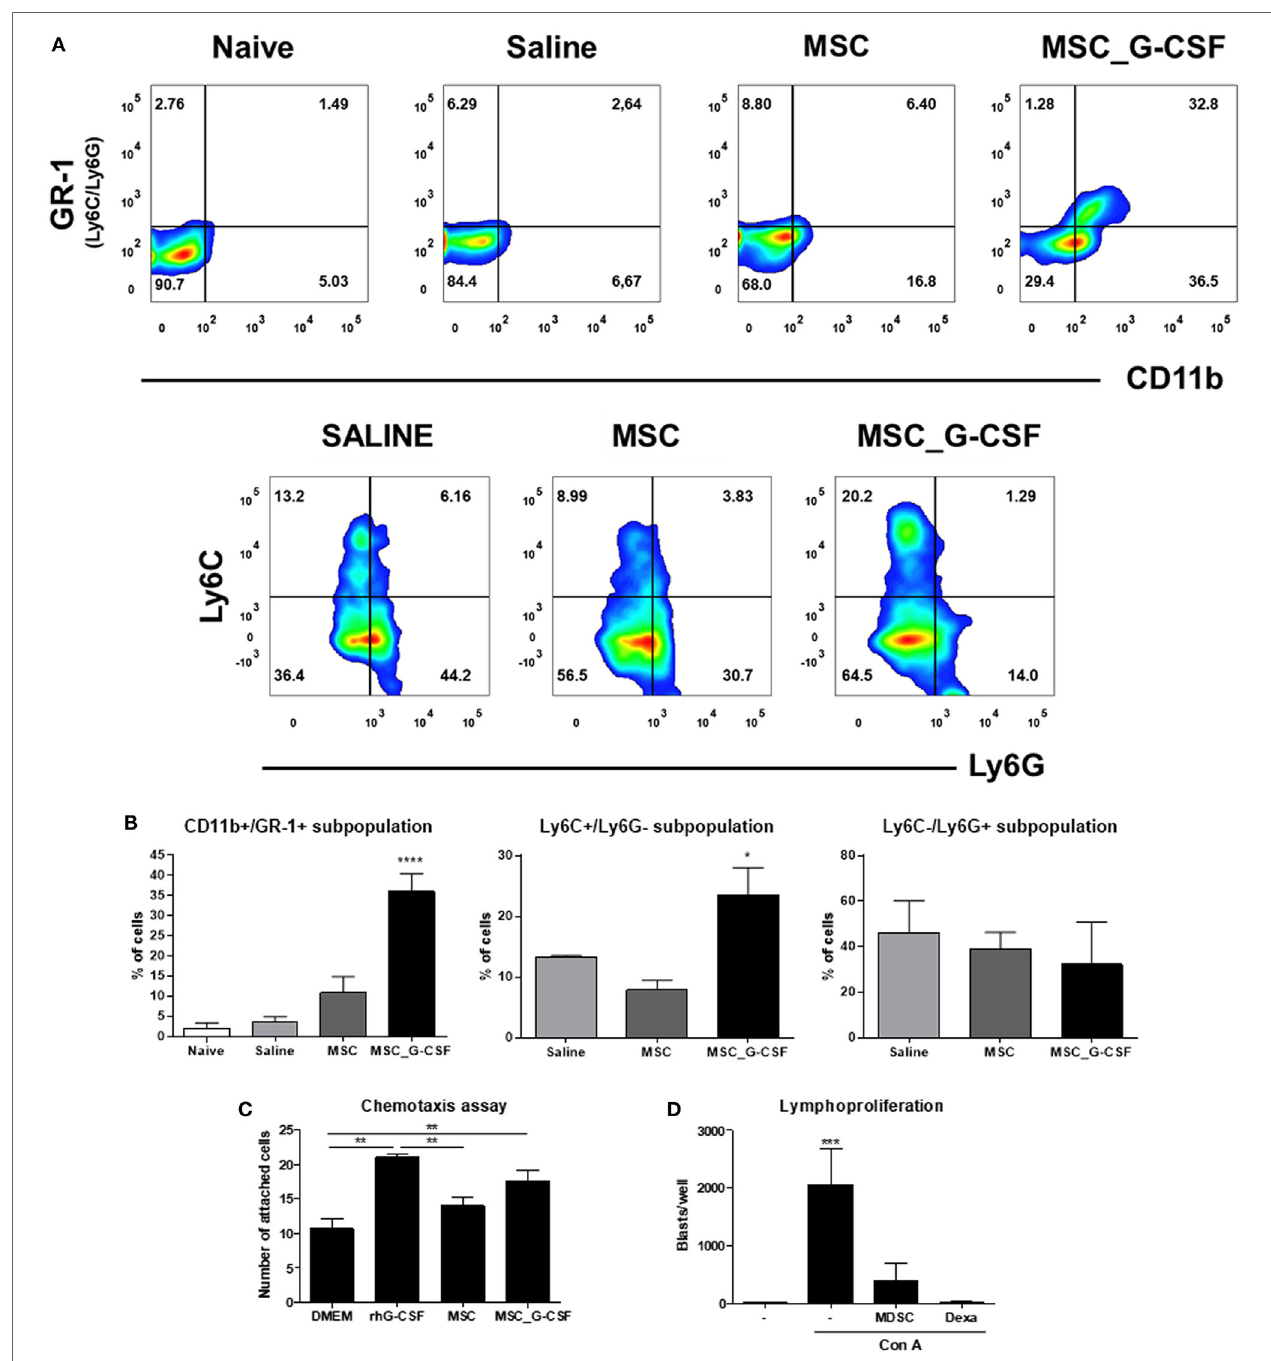
FigUre 2 | Granulocyte-colony stimulating factor (G-CSF) overexpression in mesenchymal stem cells (MSCs) induces the mobilization of myeloid-derived suppressor cells (MDSCs) to the hearts of Trypanosoma cruzi -infected mice. (a) Flow cytometry analysis of CD11b/GR-1 and Ly6C and Ly6G subpopulations in the heart tissue of T. cruzi -infected mice treated with MSCs, MSC_G-CSF, or saline. (B) Percentage of MDSCs (CD11b + GR-1 + ) and its subpopulations M-MDSCs (Ly6C + Ly6G − ) and PMN-MDSCs (Ly6C − Ly6G + ) in the hearts of naïve and T. cruzi -infected mice from saline, MSCs, or MSC_G-CSF-treated groups. Values represent the mean ± SEM of 3–5 mice/group. (c) CD11b + GR-1 + were sorted from the bone marrow of naïve mice and used in chemotaxis assay in transwell chambers containing Dulbecco’s Modified Eagle’s Medium, human rG-CSF, or conditioned medium of MSCs or MSC_G-CSF. The number of migrating cells was determined 24 h after incubation. Values represent the mean ± SEM of biological replicates. (D) Splenocytes from naïve mice were stimulated with concanavalin A in the presence of MDSCs (CD11b + GR-1 + ) purified from the hearts of MSC_G-CSF-treated T. cruzi -infected mice, or dexamethasone (1 µM) as a positive control, in a 96-well plate. The number of blasts in proliferation was determined using a high content imaging system. Values represent the mean ± SEM of replicates. ** P < 0.01; *** P < 0.001.